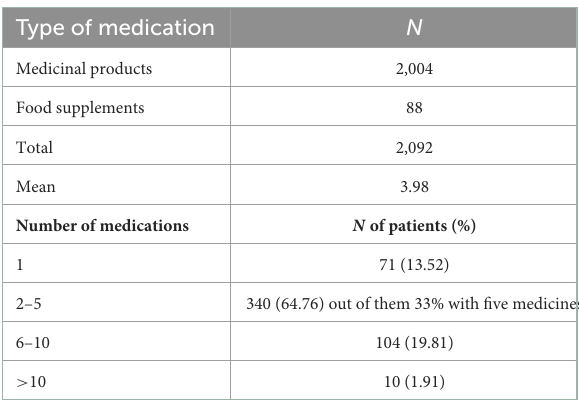
TABLE 2 Reported diseases. TABLE 3 Prescribed type and number of medication